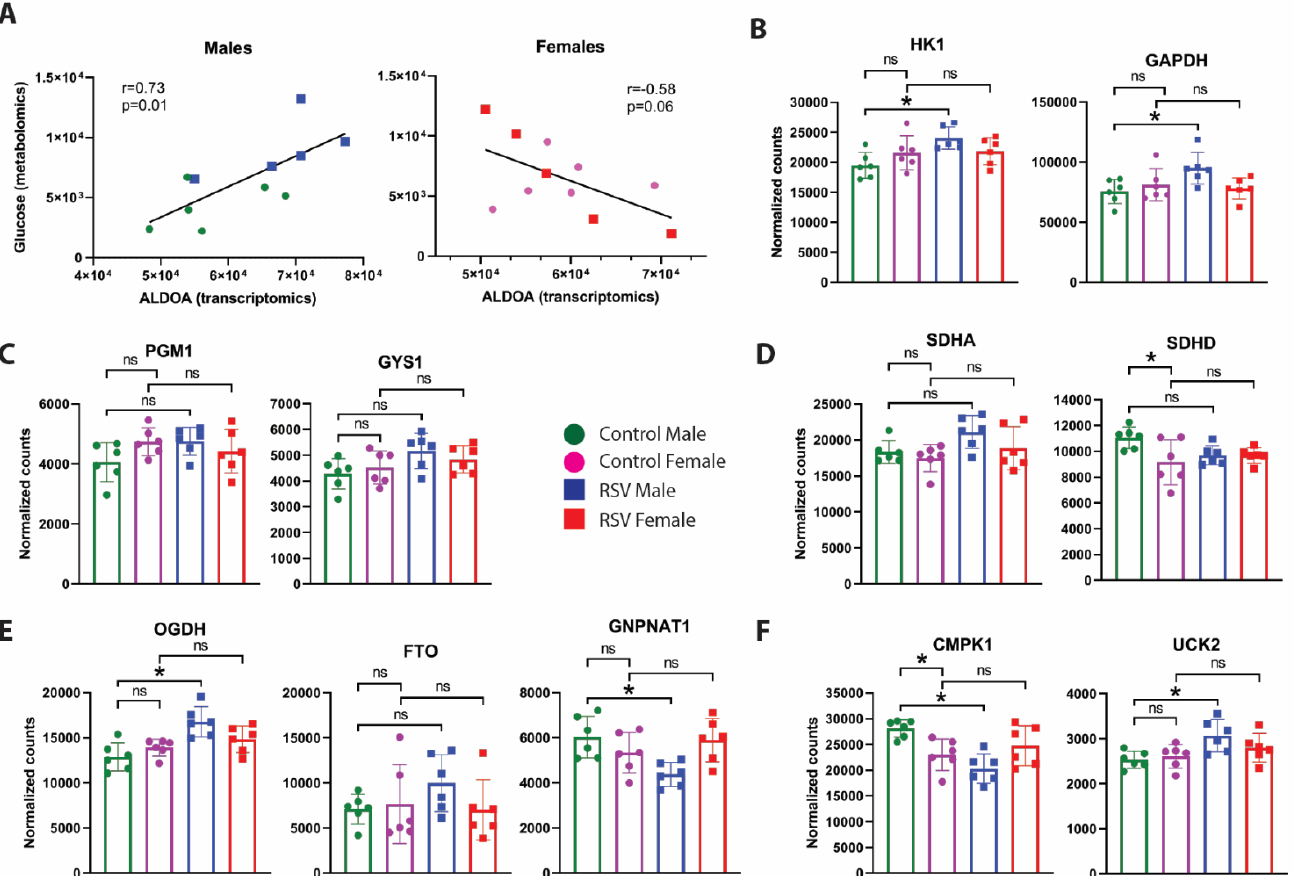
Figure 4. ( A ) Correlations between metabolomic data ( α‐ D ‐ glucose metabolism by Biolog) and transcriptomic data (aldolase expression by RNA ‐ seq) for glucose metabolism specifically. Blue, males; red, females. ( B – F ) Direct comparisons of male and female data for key metabolic markers in RNA ‐ seq analysis of metabolic markers and pathways in nasal epithelial cells derived from male with or without history of infant RSV infection. ( B ) Expression of markers of glycolysis. ( C ) Markers of glycosylation and glycogenesis. ( D ) Succinate metabolism. ( E ) Alpha ‐ ketoglutarate/acetyl ‐ CoA metabolism. ( F ) Uridine metabolism. Green = NAEC from male children who were RSV uninfected during infancy ( n = 6). Purple = NAEC from female children who were RSV uninfected during infancy ( n = 6). Blue = NAEC from male children who were RSV infected during infancy ( n = 6). Red = NAEC from female children who were RSV infected during infancy ( n = 6). * p < 0.05 by ANOVA/Tukey multiple testing. ns, not significant.